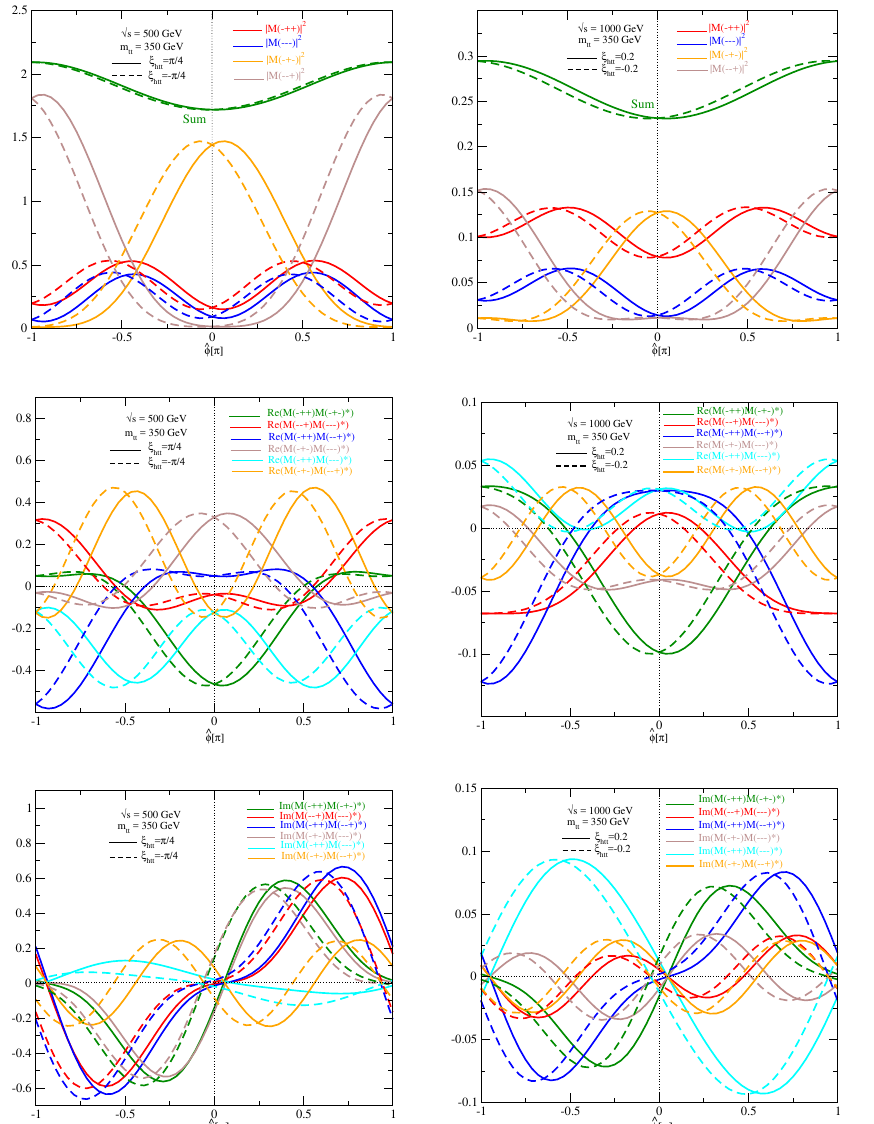
Figure 4 . The azimuthal angle distribution of the 16 helicity amplitudes combinations M for (cid:11) = 1 ( e (cid:22) e annihilation) at p s = 500 GeV for (cid:24) L R (cid:0) 1000 GeV for (cid:24) htt = 0 : 2 (right panels). We set cos (cid:18) = 0, cos ^ (cid:18) = 0 : 5 and m t (cid:22) t = 350 GeV in all the (cid:6) plots. Solid curves are for (cid:24) htt > 0, and dashed curves are for (cid:24) htt < 0.